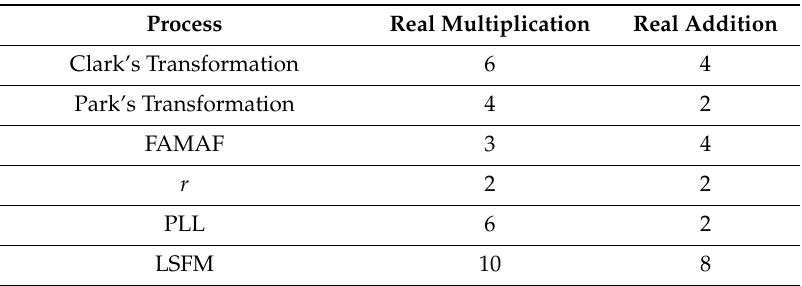
Table 1. The real multiplication and real addition of each part of the FA-PSMA. Process Real Multiplication Real Addition Clark’s Transformation 6 4 Park’s Transformation 4